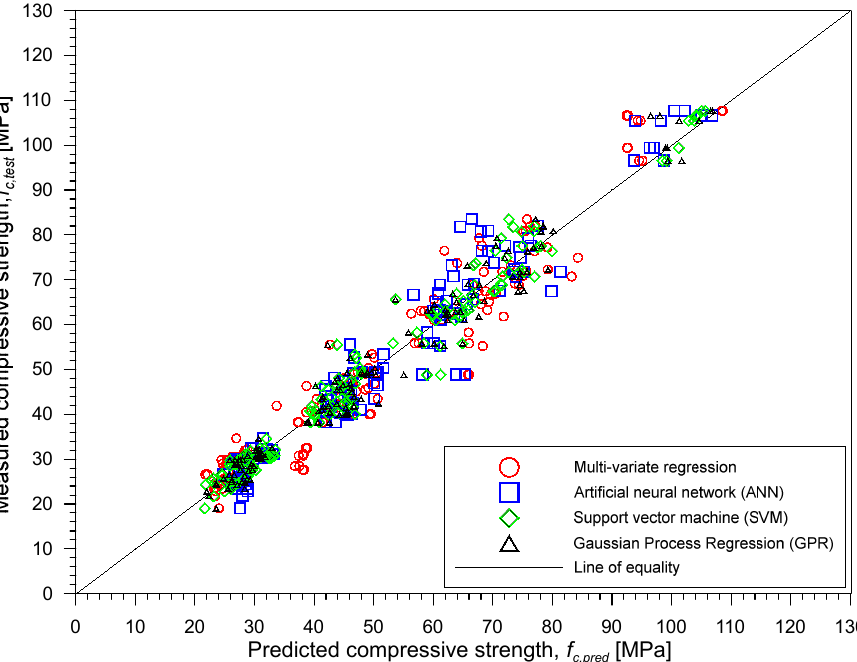
Figure 13. Correlation between measured and predicted compressive strength of concrete using the combination of five parameters from four different machine learning methods. Table 10. R-squared comparison between the different methods used in the study.